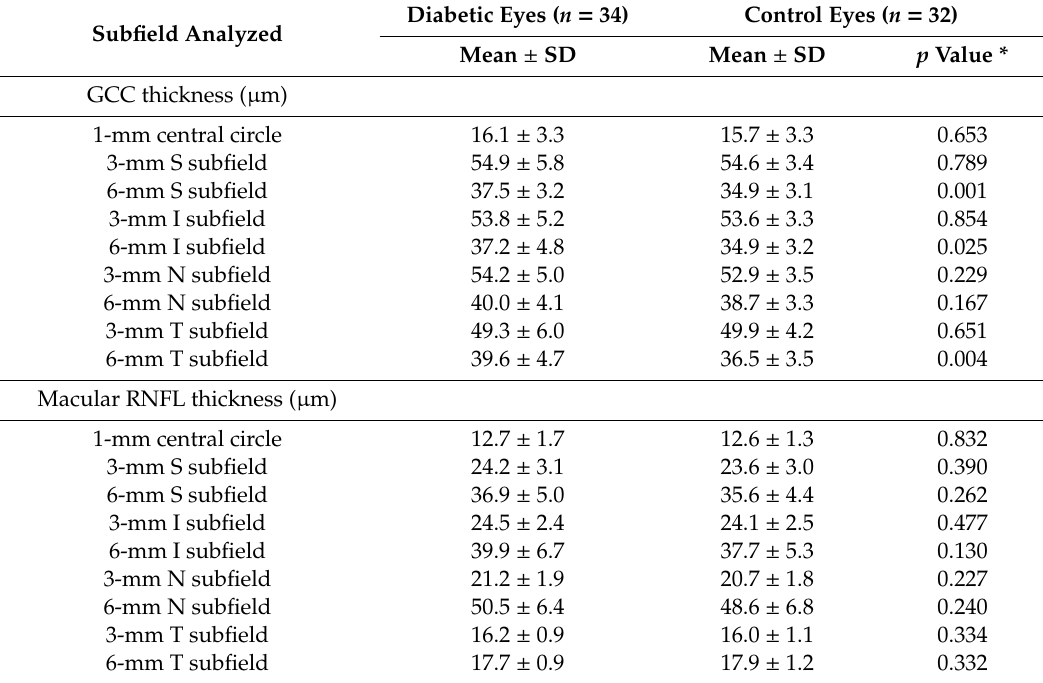
Table 2. GCC and RNFL thickness analysis of diabetic eyes compared with control